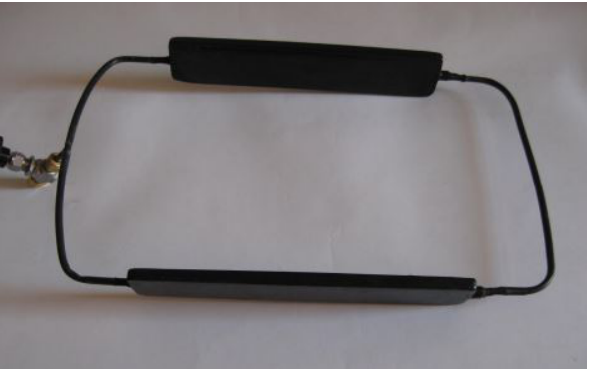
Figure 3. Flat loop thermosyphon built with a polyamide polymer composite